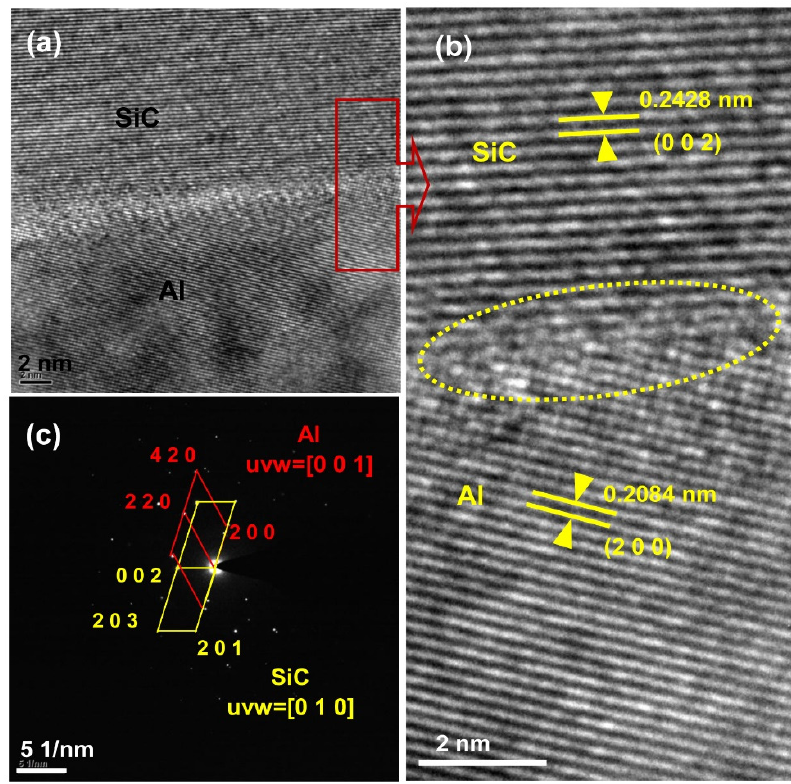
Figure 9. HRTEM images ( a , b ) and SAED patterns ( c ) of the SiC–Al interface. SEM, EDS, and TEM analyses were performed on SiC ceramics infiltrated by Al base alloy at 900 °C for 6 h to investigate the in situ synthesis process of Ti 3 Si(Al)C 2 . From Figure 10a,b, and Table 1, it can be seen that Ti 3 Si(Al)C 2 is generated in situ on the SiC ceramic during infiltration. The size of the SiC grains gradually decreased as the Ti 3 Si(Al)C 2 grains grew. A higher magnification image of the sample is shown in Figure 10), where a white Ti 3 Si(Al)C 2 phase can be observed near a grey SiC phase and a black Al–Si alloy structure. The EDS line scanning analyses in Figure 10d,e indicate that a transition layer of Al base alloy exists on the SiC phase, from which we can infer that molten Al penetrates into the SiC ceramic samples. According to the distributions of Ti, Si, Al, and C (Figure 10h–k, respectively), it can be seen that white phase mainly contains Ti, Si, C, and a small amount of Al, thus corresponding to the Ti 3 Si(Al)C 2 phase. The lower left corner is mainly Al, whereas the lower right corner contains Si and C; therefore, it is inferred that the lower left is Al and the lower right is SiC. Al distribute in the interface between Ti 3 Si(Al)C 2 and SiC, which further illustrates that Ti 3 Si(Al)C 2 is formed by the reaction of Ti with Al and SiC. At the same time, it can be deduced that Al atoms were substituted into a small number of Si sites in Ti 3 SiC 2 , thus forming Ti 3 Si(Al)C 2 .